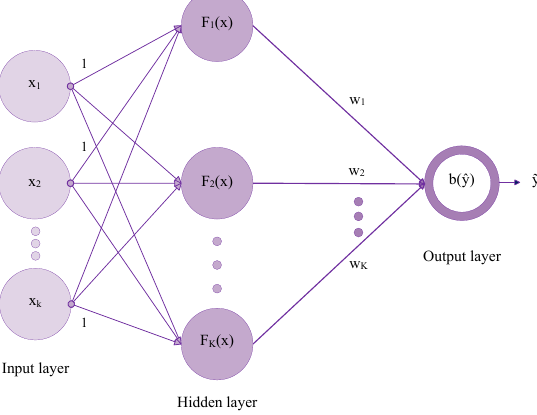
Figure 1. Overview of the final structure of the